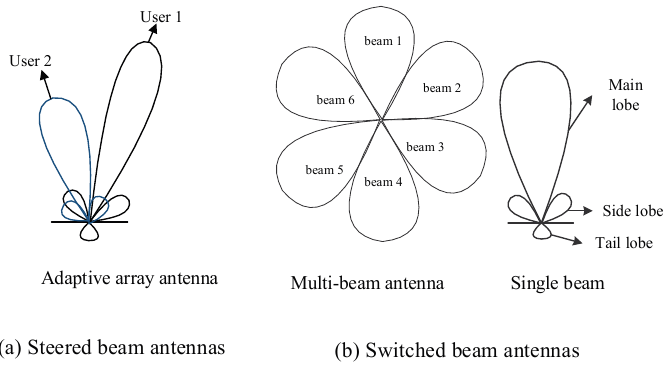
Figure 1. Two main kinds of directional antennas. ( a ) Steered beam antennas; ( b ) Switched beam